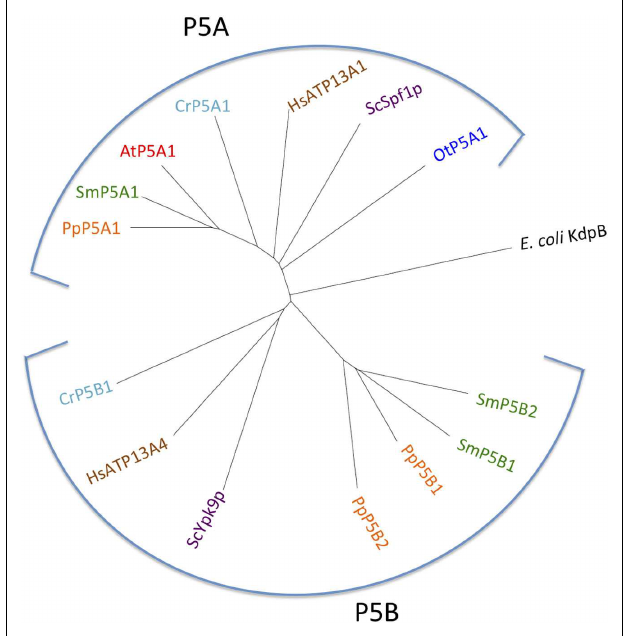
FIGURE 13 | Phylogenetic tree of P5ATPases (having unknown transport activity). Accession numbers for sequences are given in Table 2 . For comparison, the following outliers were included: a bacterial P1A ATPase E. coli KdpB (P03960), the S. cerevisiae pumps ScSpf1p